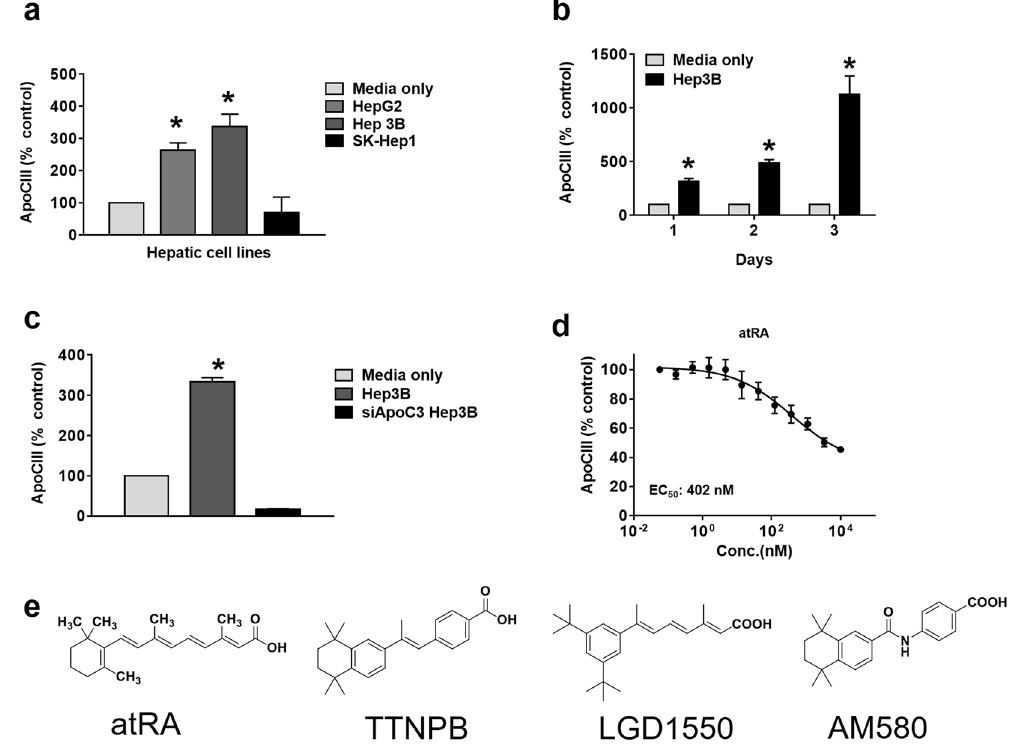
Figure 1. ApoC-III assay development and high throughput screening. ( a ) Secreted ApoC-III levels were measured in various hepatic cell lines (HepG2, Hep3B and SK-Hep1) after 3 days of incubation using an ApoC-III HTRF assay. Media only (no cells) readings represent background counts and were subtracted from all the raw data. ( b ) Hep3B cells were cultured for differing periods of time and secreted ApoC-III levels were measured by HTRF assay. ( c ) Hep3B cells were transfected with the siApoC-III as a positive control. ( d ) atRA was identified as a potential ApoC-III inhibitor in the primary screen. ( e ) Chemical structures of the RAR agonists, atRA, TTNPB, LGD1550 and AM580. Representative triplicate data is shown from at least three independent